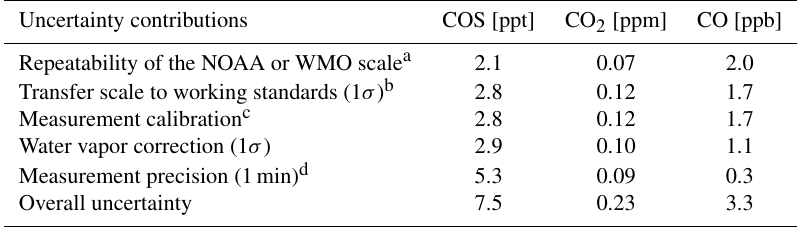
a For COS: defined as the standard deviation of the measurements associated with the cylinder calibration. For CO 2 and CO: certified by the WMO central calibration laboratory (NOAA/ESRL). b Average uncertainty over four cylinders in Table 2 (method 3). c Using the single bias correction (see Sect. 2.2.2) it is the same as transferring the scale to the working standards. d The standard deviation over minute-averaged cylinder measurements after drift correction with reference measurements every 30min (Table 3).